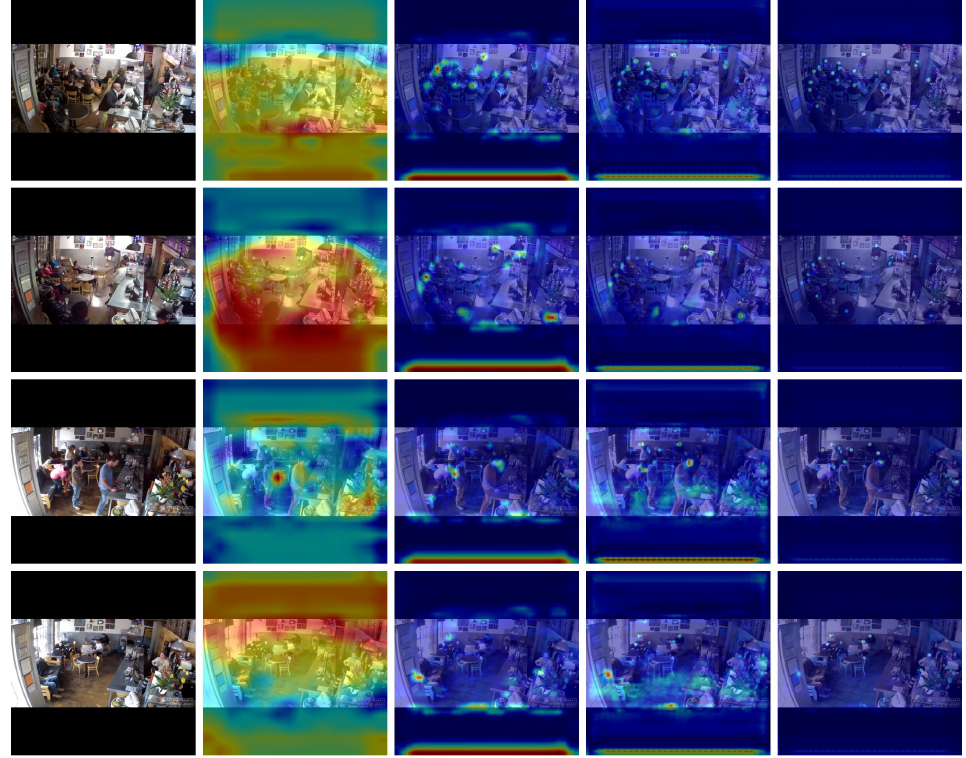
Figure 5. Input images and the CAMs of the M 5 , M 4 , M 3 , and M 2 are displayed in order from left to right.